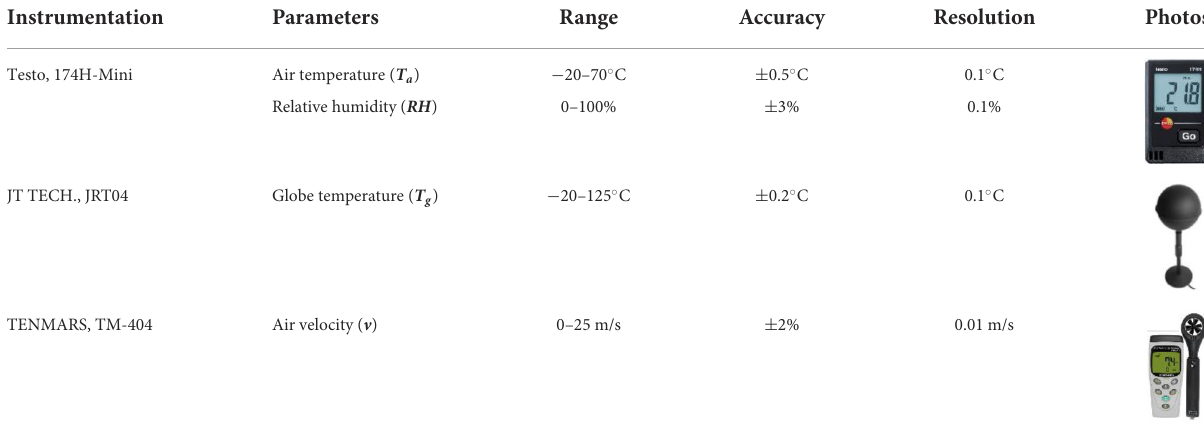
TABLE 1 Specifications of the measuring instrument used in this